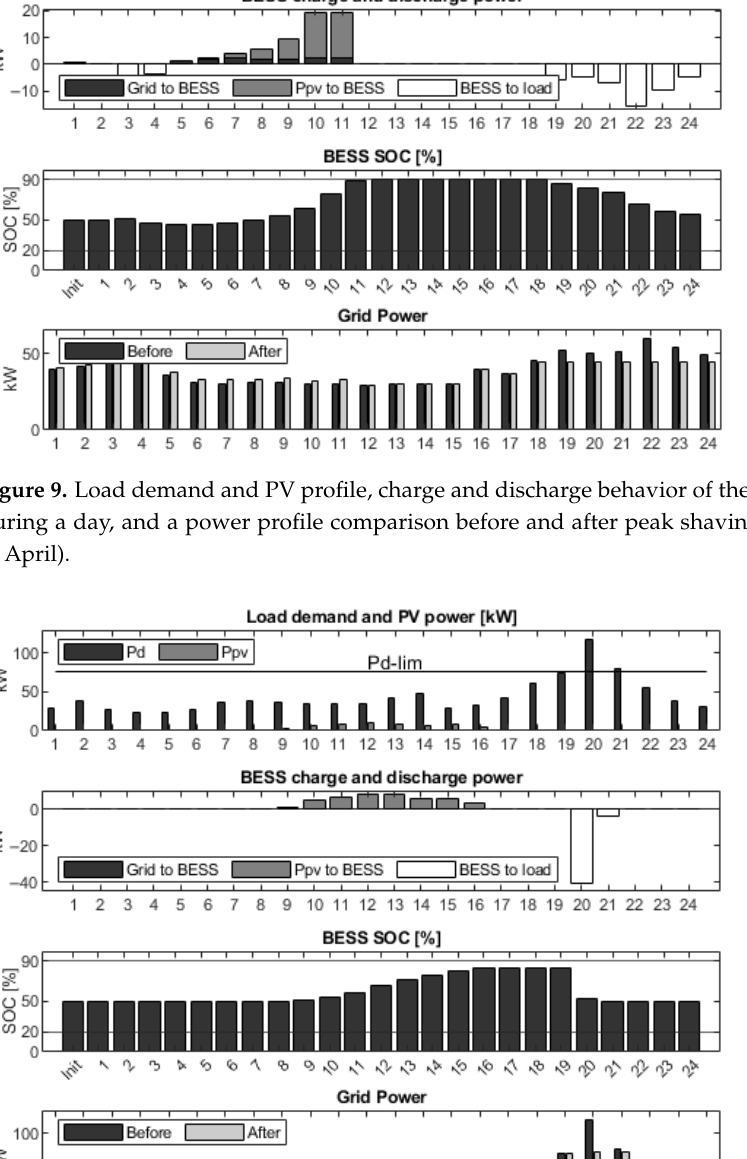
Figure 10. Load demand and PV profile, charge and discharge behavior of the BESS as well as SOC during a day, and a power profile comparison before and after peak shaving operation (the 9th of March). The RMSE , E b − disch and the P d − lim for the three predicted days can be seen in Table 8 and the effect on the load demand peak can be seen in Table